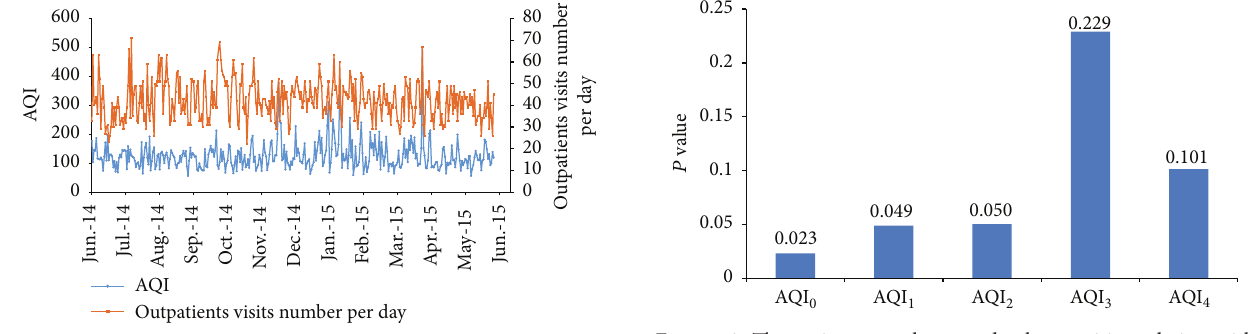
Figure 1: A total of 15373 patients were enrolled in this study from June 2014 to May 2015, and the AQI was recorded within same interval. The average patients number per day and AQI were 42 (22– 71) and 125 (56–500), respectively.